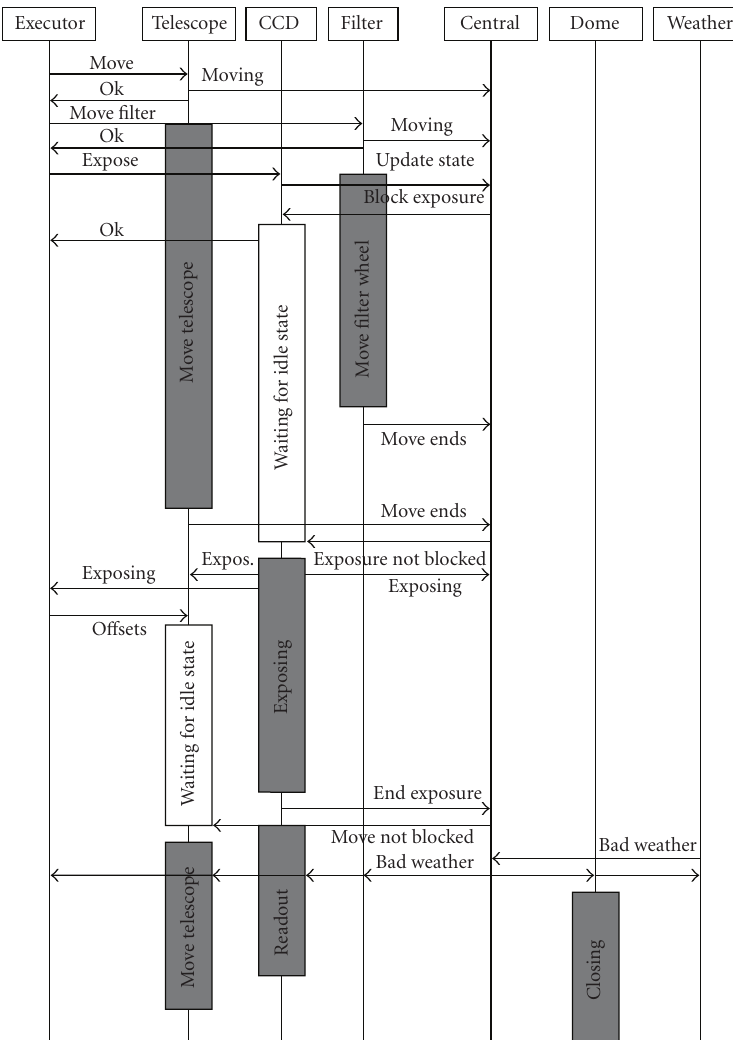
Figure 2: Interactions of devices using states for synchronisation. Note how various block are placed to keep telescope from moving and camera from exposing. The observation is interrupted by bad weather reported from a weather sensor, which closes the roof.